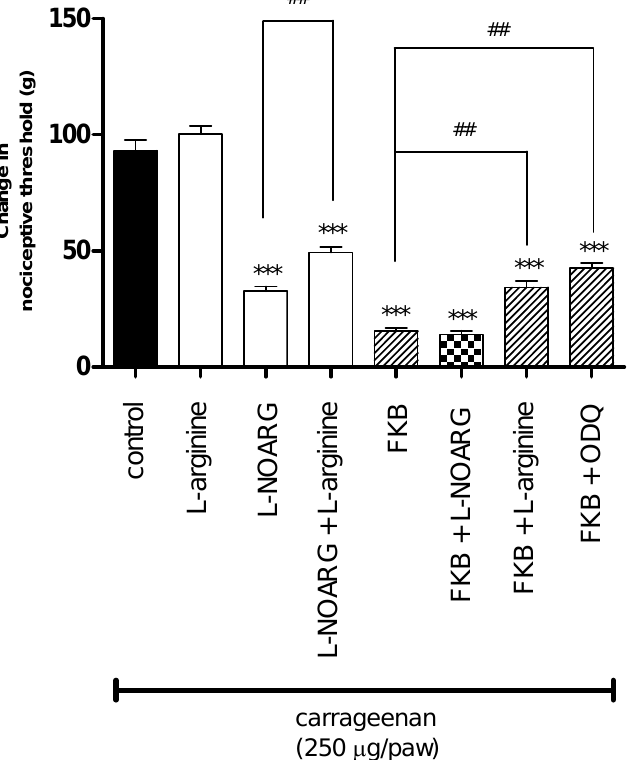
Figure 3. The effect of pre-treatment of animals with L -arginine (25 µg/paw, i.pl.), NG-nitro- L -arginine ( L -NOARG; 35 μ g/paw, i.pl.) or ODQ (50 μ g/paw, i.pl.) on the peripheral antinociceptive effect of FKB (500 µg/paw) against carrageenan-induced hyperalgesia test in rats. Each column represents the mean ± S.E.M. ( n = 6). *** p < 0.001 when compared with control group; ## p < 0.01 when compared with L -NOARG-treated or FKB-treated group (One-way ANOVA followed by Dunnett’s post hoc